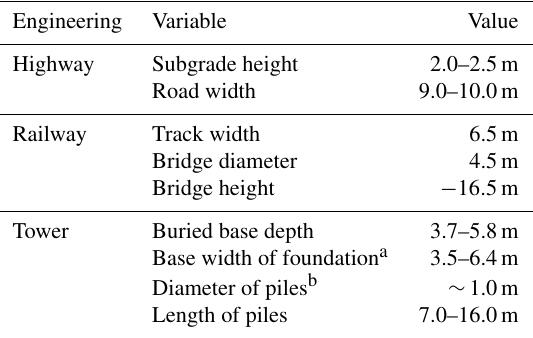
Table G1. Physical parameters of the engineering infrastructure near the permafrost slopes. Two types of foundations are applied in the construction of the power and communication towers. a The cone cylinder spread footing. b The drilled